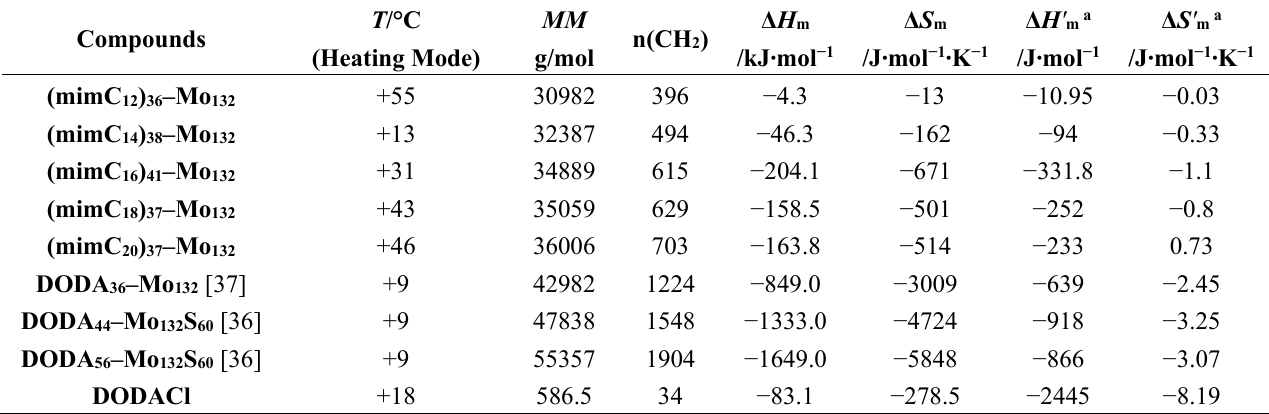
Table 2. Temperatures, melting enthalpy and entropy changes of the phase transitions between the glassy state and the liquid crystal phases observed for the materials exhibiting liquid crystalline properties. Temperatures are given for the peaks observed by DSC measurements during the second heating